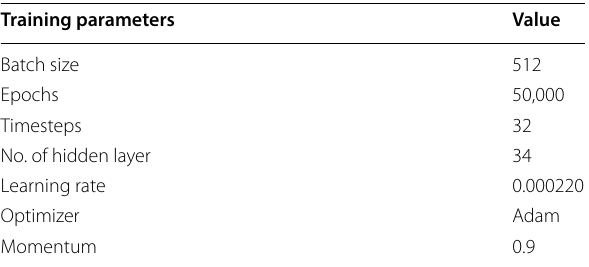
Table 3 Training specification for our proposed GRU